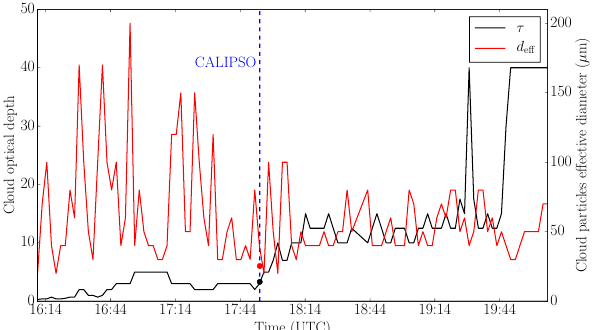
Figure 15. Time series of optical depth and effective diameter re- trieved from FIRR measurements performed on 21 February 2015. The values retrieved from CALIPSO instruments 33km east of the measurement site are indicated by large dots.